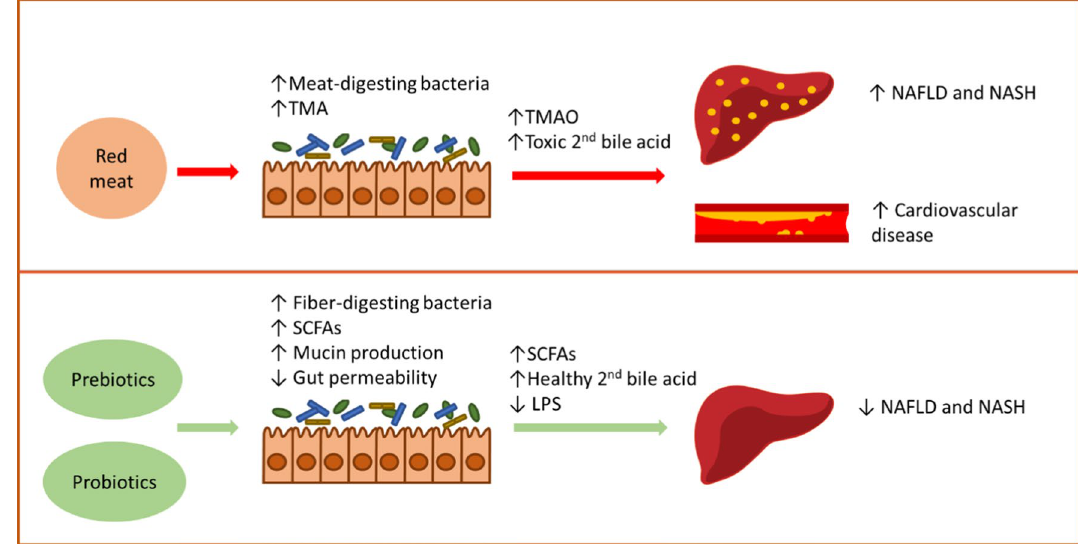
Fig. 2 Dietary modification affects gut and liver health. Dietary modifications and supplementation of additives can improve the gut health by shaping the gut toward a healthy population that produces beneficial metabolites, such as short-chain fatty acids (SCFAs). SCFAs can then be utilized by intestinal cells to produce essential substances, such as lubricating mucus and tight-junction proteins, which are required to maintain the intestinal barrier and proper bowel movement. Meanwhile, excessive intake of red meat containing a high amount of choline and L-carnitine can increase the trimethylamine-N-oxide (TMAO) levels, leading to cardiovascular disease (CVD), non-alcoholic fatty liver disease (NAFLD), non-alcoholic steatohepatitis (NASH), and